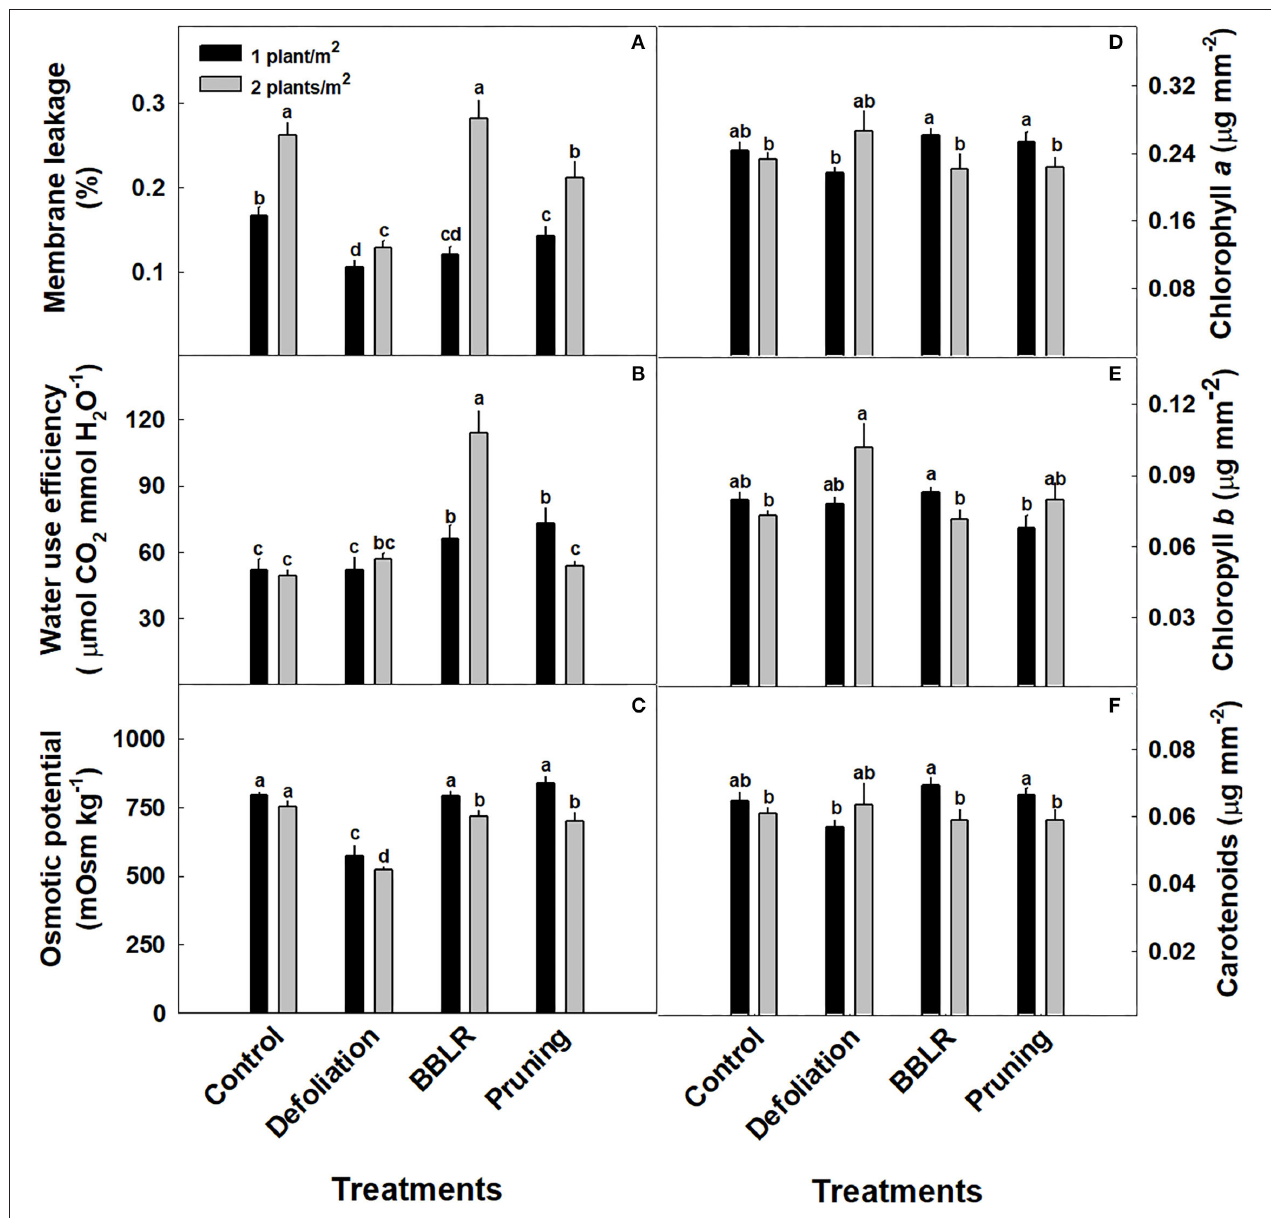
FIGURE 7 | Effects of plant density (1 or 2 plants/m 2 ) and plant architecture modulating treatments on medical cannabis plants. Membrane leakage (A) , Water use efficiency (B) , Osmotic potential (C) , Chlorophyll a (D) , Chlorophyll b (E) , carotenoids (F) . The results are mean and SE ( n = 6). Different letters above the bars represent significant differences between treatments by Tukey HSD test at α =